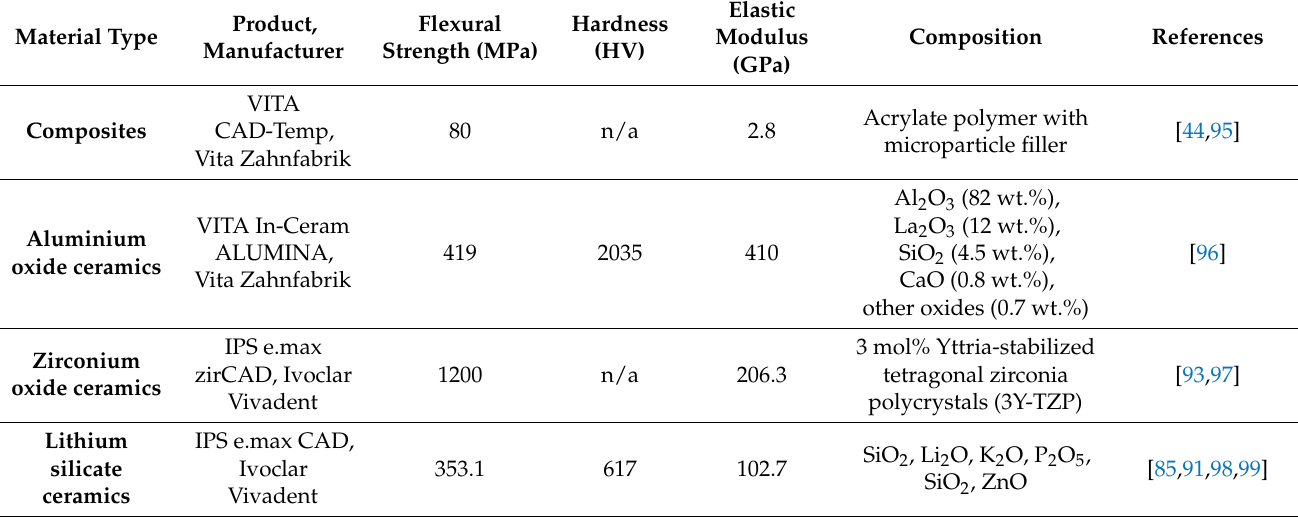
Table 2. Mechanical properties and chemical composition of selected CAD/CAM